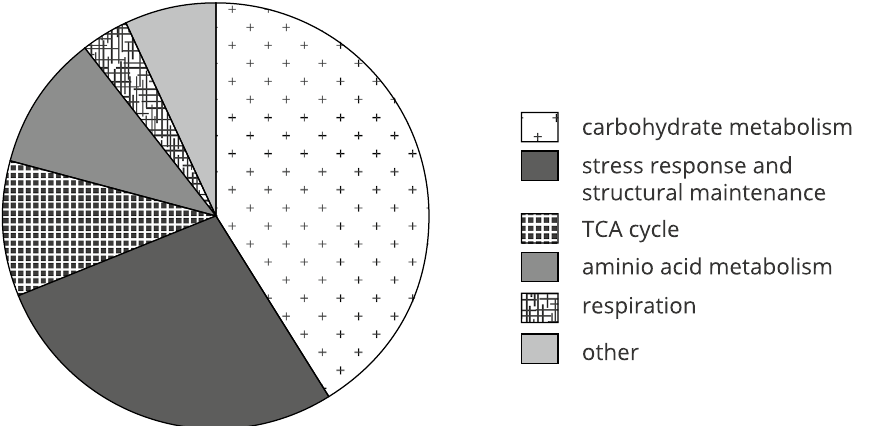
Figure 5. Assignment of glucose-concentration-dependent proteins to functional categories. Glucose- concentration-dependent spots were detected in the fluorescence scans of 2D-DIGE gels by comparing the proteomes of cells grown at different initial glucose concentrations (0.1% or 2% (w/v)) using ANOVA. The glucose-concentration-dependent proteins subsequently identified by LC/ESI–MS/MS were categorized according to their function. Proteins with multiple known functions were assigned to different functional categories accordingly. The category "other" subsumes proteins not considered in any other functional